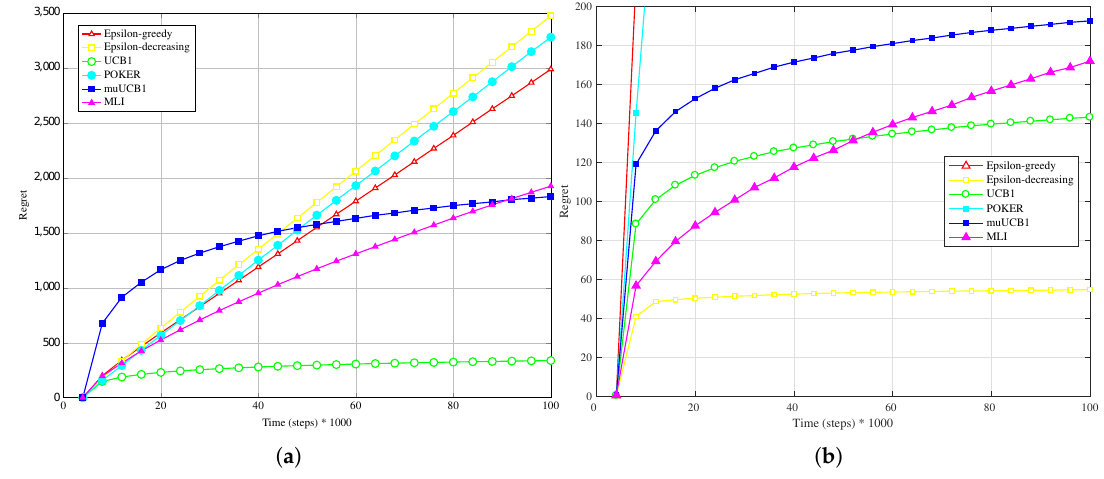
Figure 7. Performance in terms of regret of the six considered algorithms, with an exponential distribution for the reward PDF and T U / T M = 1. ( a ) Hard configuration; ( b ) Easy